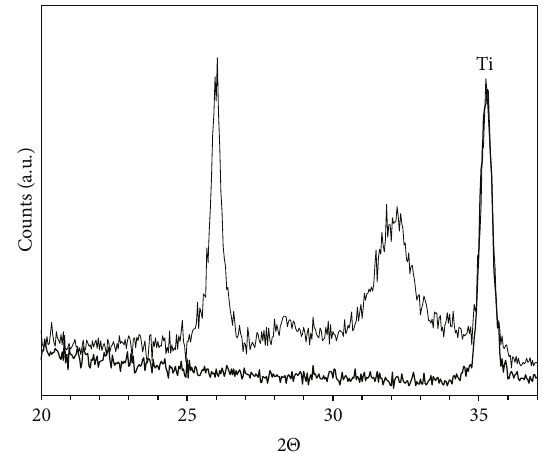
Figure 10: X-ray diffraction on TS + AT-I before (thick line) and after (thin line) immersion in SBF solution. The diffraction peaks at 2 Θ values 26, 28, and 32 ∘ correspond to crystalline hydroxyapatite. The diffraction spectra are normalised to the titanium peak at 2 Θ =